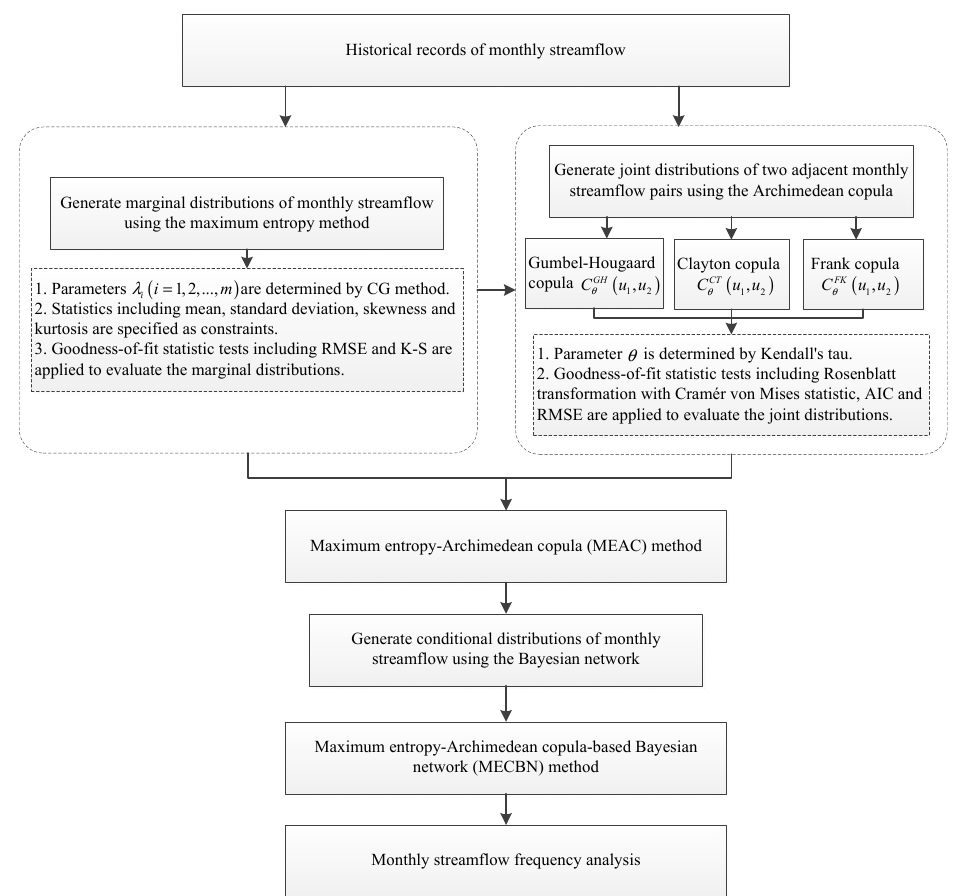
Figure 1. General framework of the maximum entropy-Archimedean copula-based Bayesian network (MECBN).